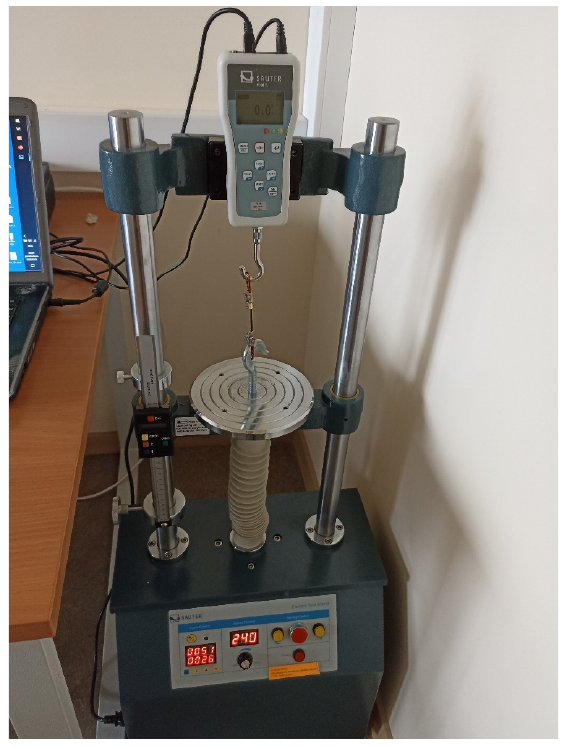
Figure 1. Test bench for mechanical testing; Sauter TVM 5000N230.